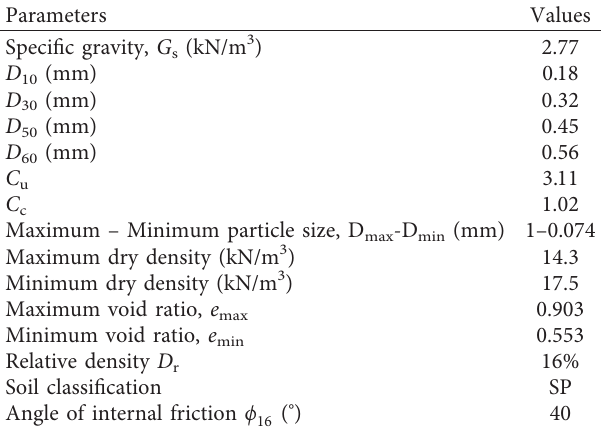
Table 1: Properties of the material used in the experiment. Parameters